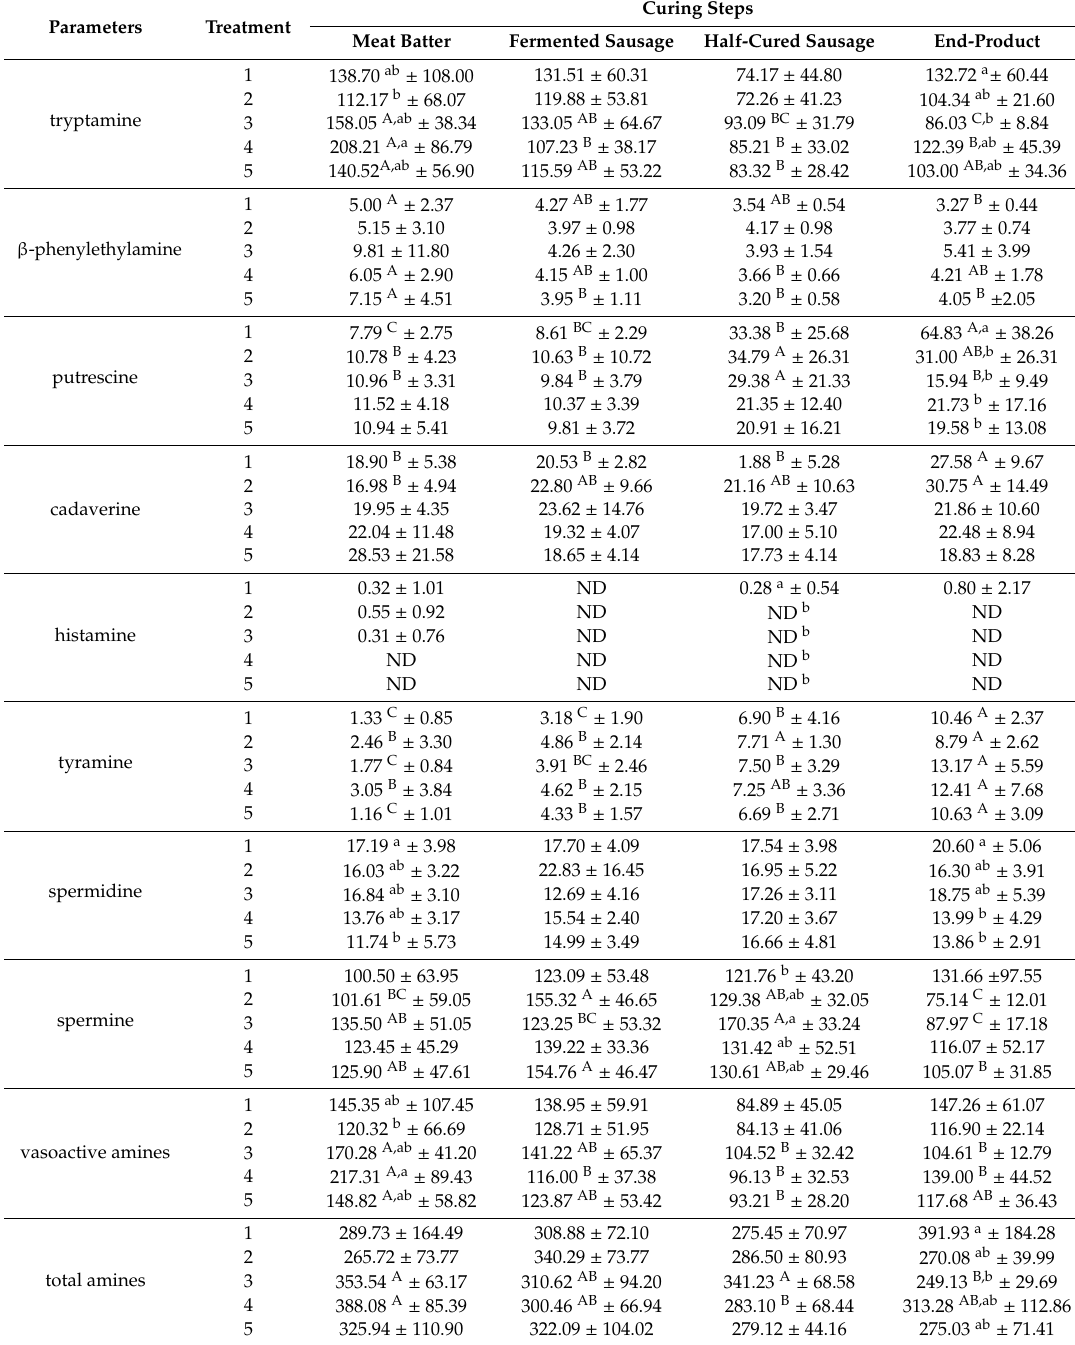
Table 3. E ff ect of starter cultures on the content in biogenic amines (mg / kg fresh weight) of smoked fermented